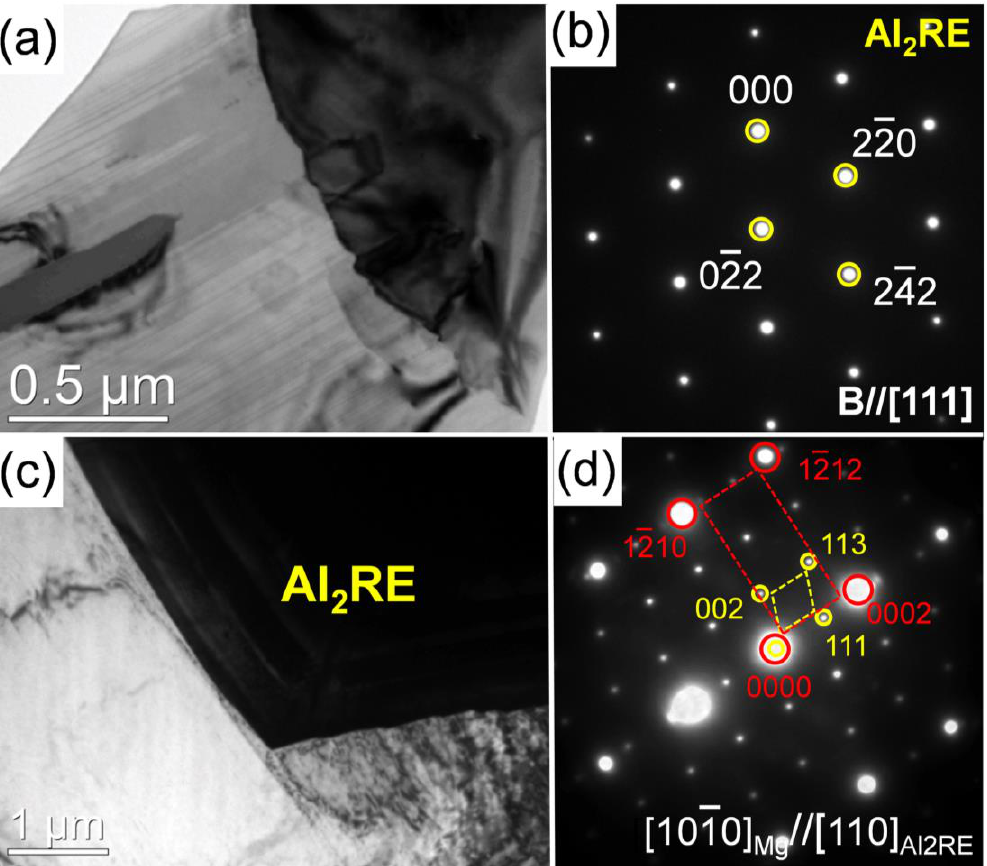
Figure 10. BF-TEM images along with the corresponding SAED patterns of the polygonal phases in as-cast alloy: ( a , b ) 0.5Zn-1.0Al and ( c , d ) 0Zn-1.0Al.